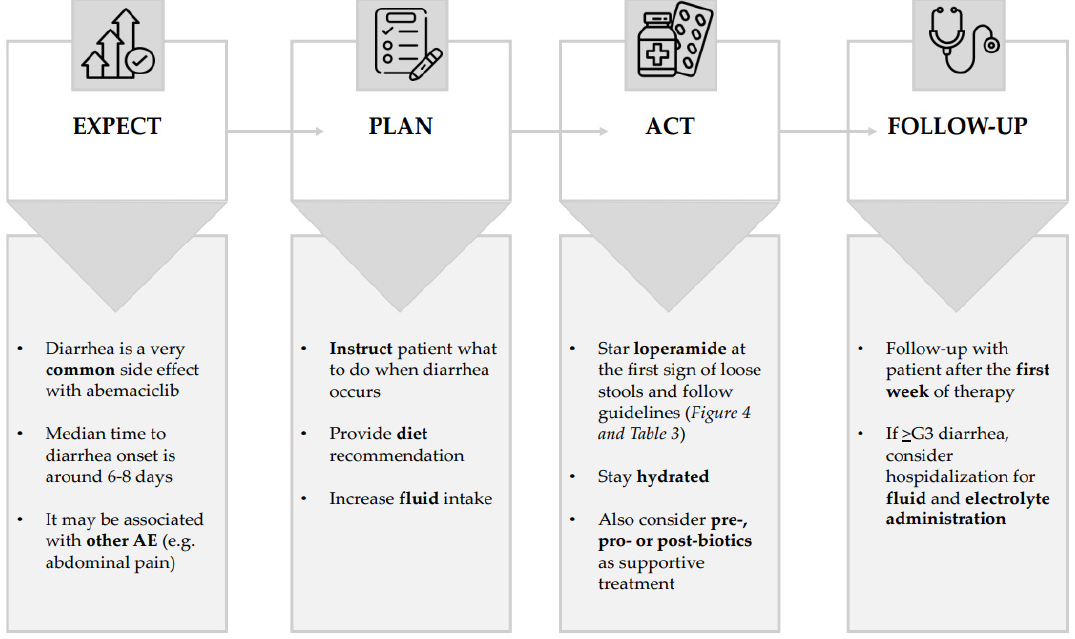
Figure 5. Simplified representation of the four steps in the management of abemaciclib-induced di- arrhea. Table 3. Synoptic table on the guideline-based management of abemaciclib-induced diarrhea. Table adapted from summary of product characteristics of abemaciclib of European Medicines Agency (EMA) [32].